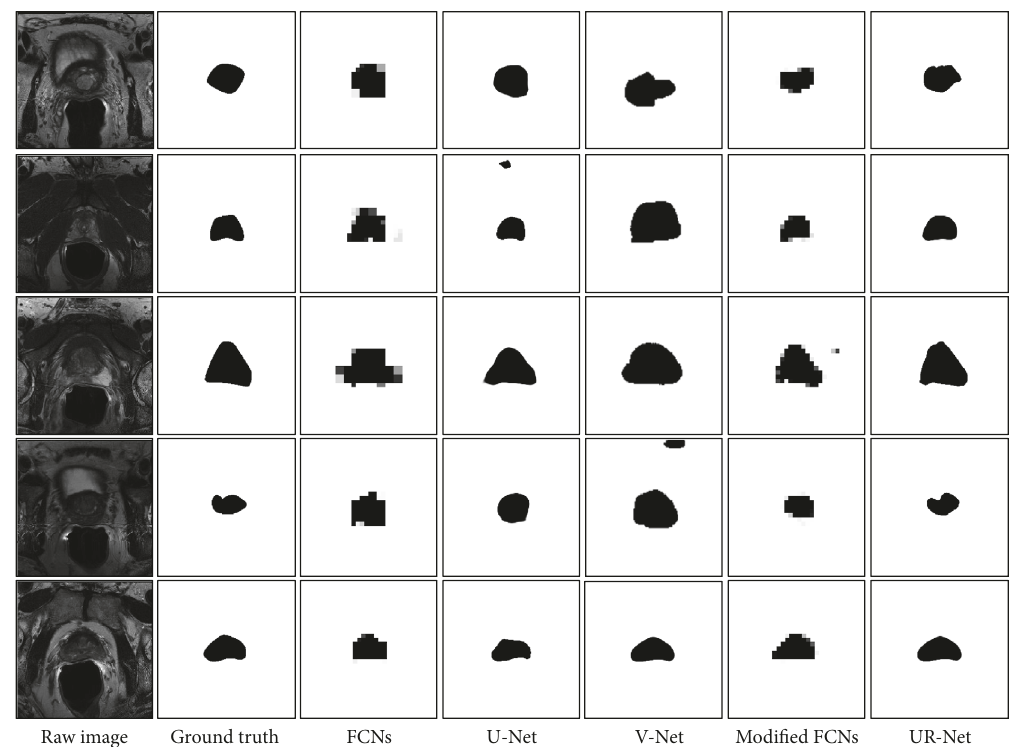
Figure 14: Segmentation results. From left to right are raw image, ground truth, the segmentation results of FCNs, U-Net, V-Net, modified FCNs, and UR-Net.